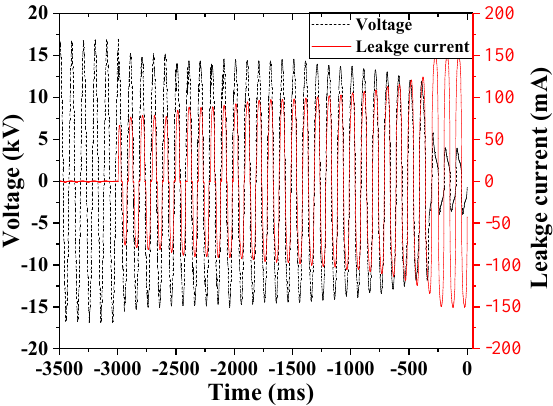
Figure 3. Waveforms of an applied voltage and the induced leakage current 3 s prior to flashover.